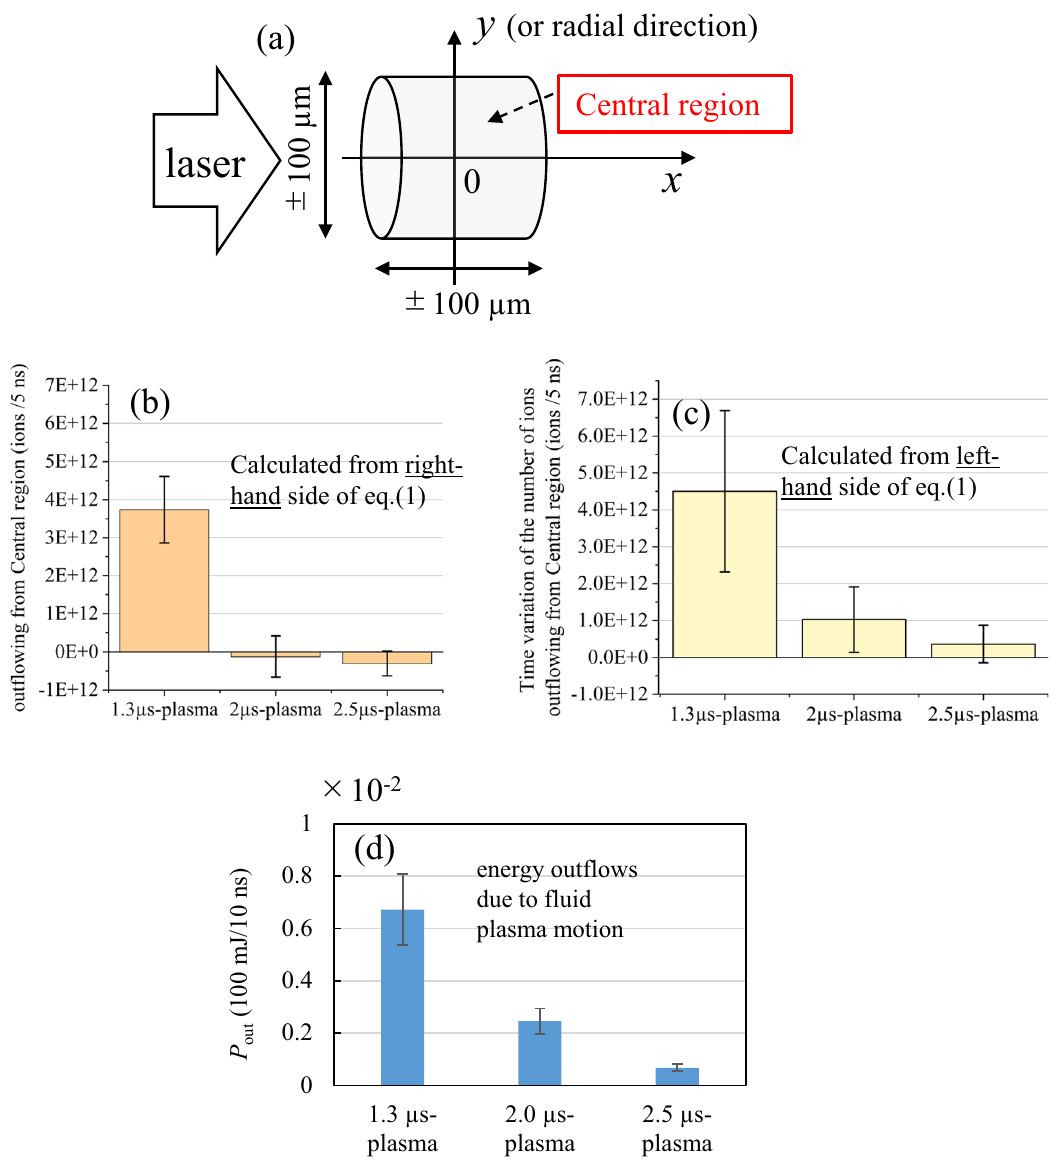
Figure 5. ( a ) Illustration of Central region, which is defined as a cylinder-shape region with 200 µm height to the x -direction (− 100 µm < x < 100 µm) and 200 µm diameter to the y -direction (− 100 µm < y = r < 100 µm). Time variation of the number of ions outflowing from Central region (/5 ns) estimated from ( b ) right-hand side and ( c ) left-hand side of Eq. (1). ( d ) Energy outflows due to fluid plasma motion from Central region estimated from the 2D profiles of internal energy density e int , pressure P , and v flow at t = 10